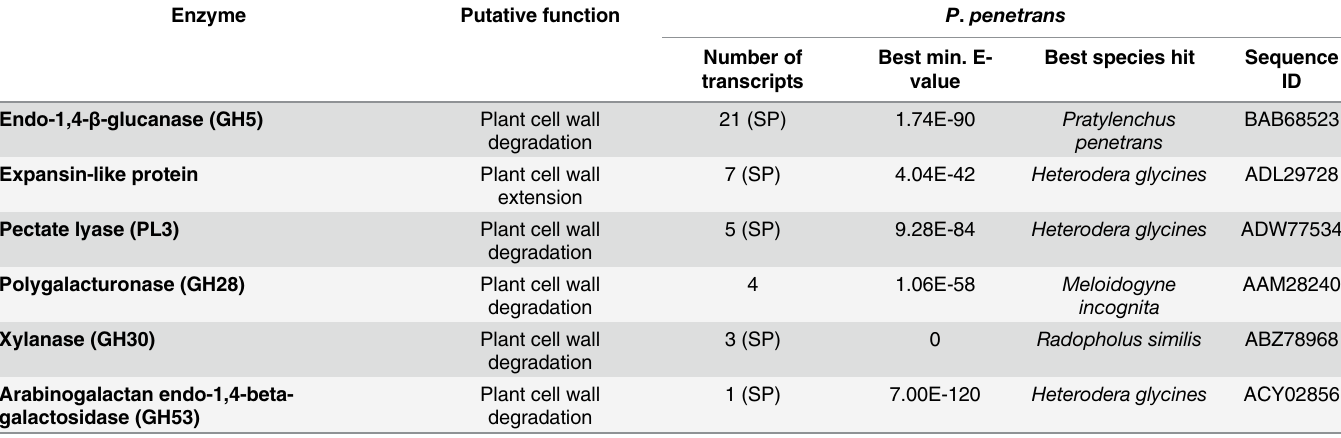
Table 3. Overview of putative cell wall modifying enzymes identified within the Pratylenchus penetrans